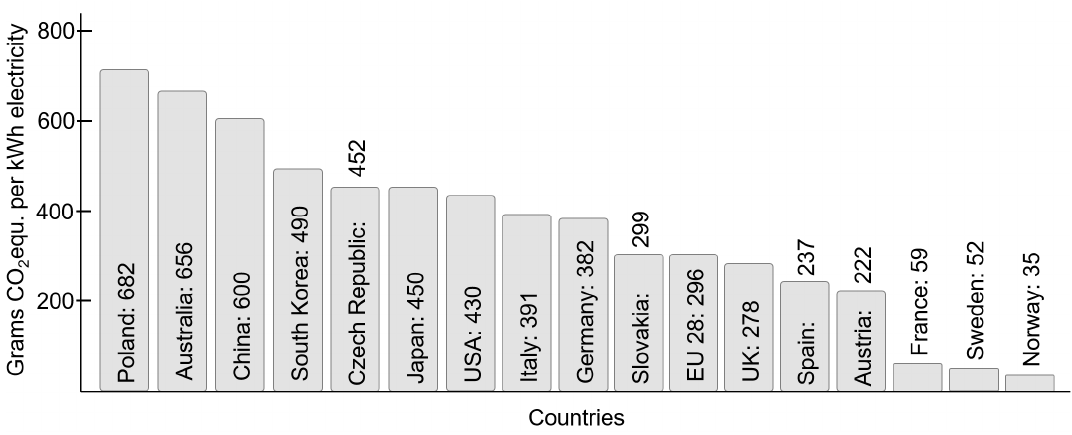
Figure 4. CO 2 -equivalent-emission intensity of electricity production in selected countries [7–9,11–13].